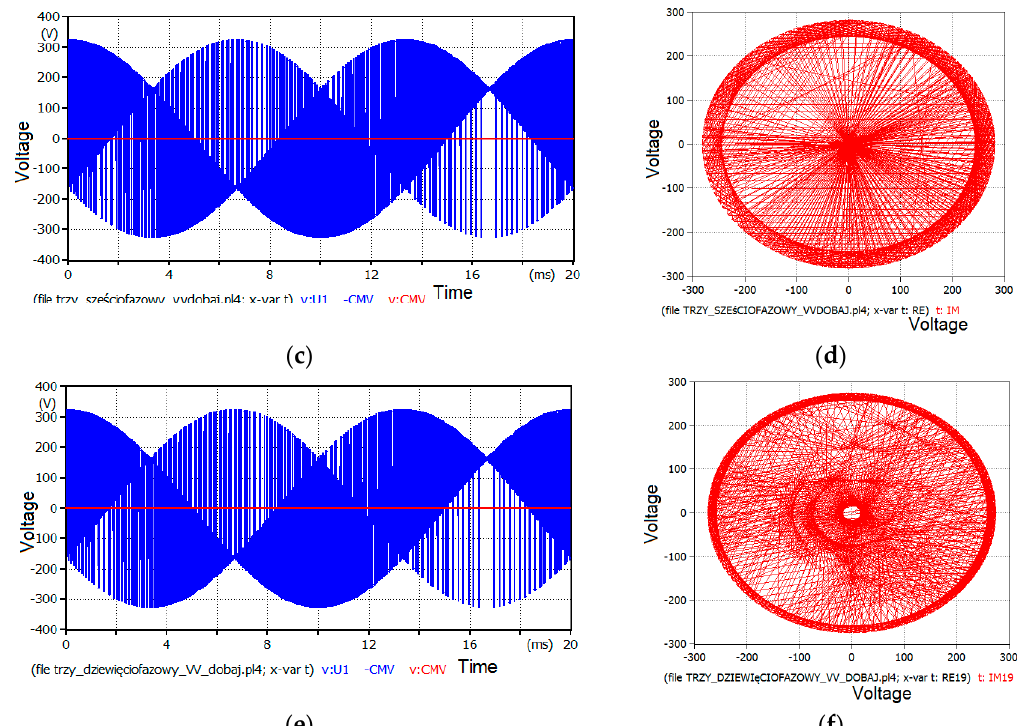
Figure 8. Output phase voltage (blue) and CMV (red) for: three-to-three-phase MC ( a ); three-to-six-phase MC ( c ); three-to-nine-phase MC ( e ). Trajectory of the output voltage for: three-to-three-phase MC ( b ); three-to-six-phase MC ( d ); three-to-nine-phase MC ( f ).